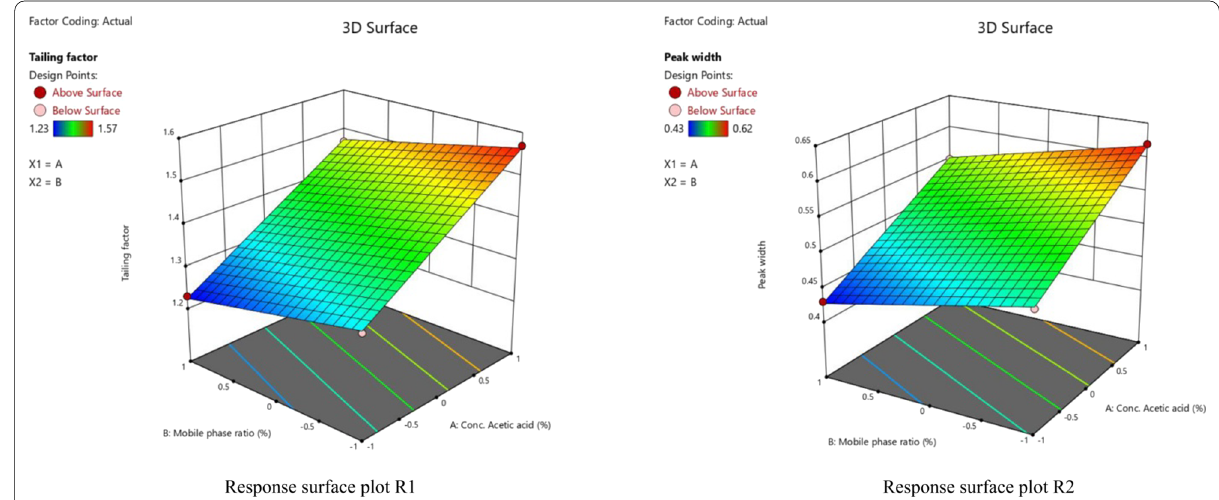
Fig. 2 Response surface plot for optimization of HPLC method for